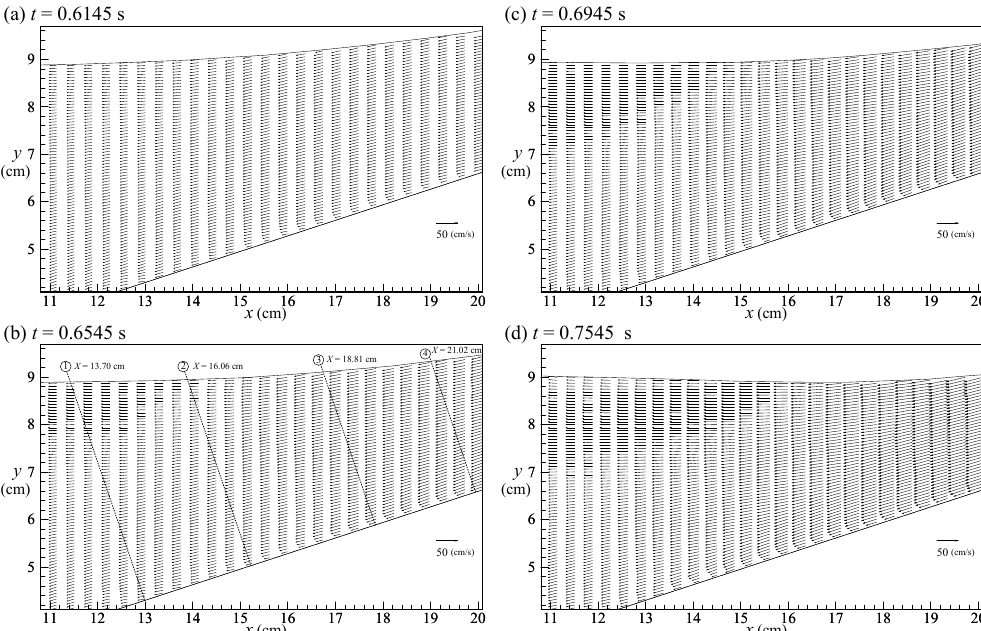
Figure 6. The spatio-temporal variation of the velocity field for t = ( a ) 0.6145 s; ( b ) 0.6545 s; ( c ) 0.6945 s; and ( d ) 0.7545 s. The velocity profiles U ( Y ), obtained at four different positions X as shown in ( b ) each with an inclined line and a circled number, are shown later in Figure 8. Note that the incipient flow separation takes place on the beach surface for X = 18.81 cm (see the inclined line with ③ in ( b )) at later time, t = 0.9210 s.